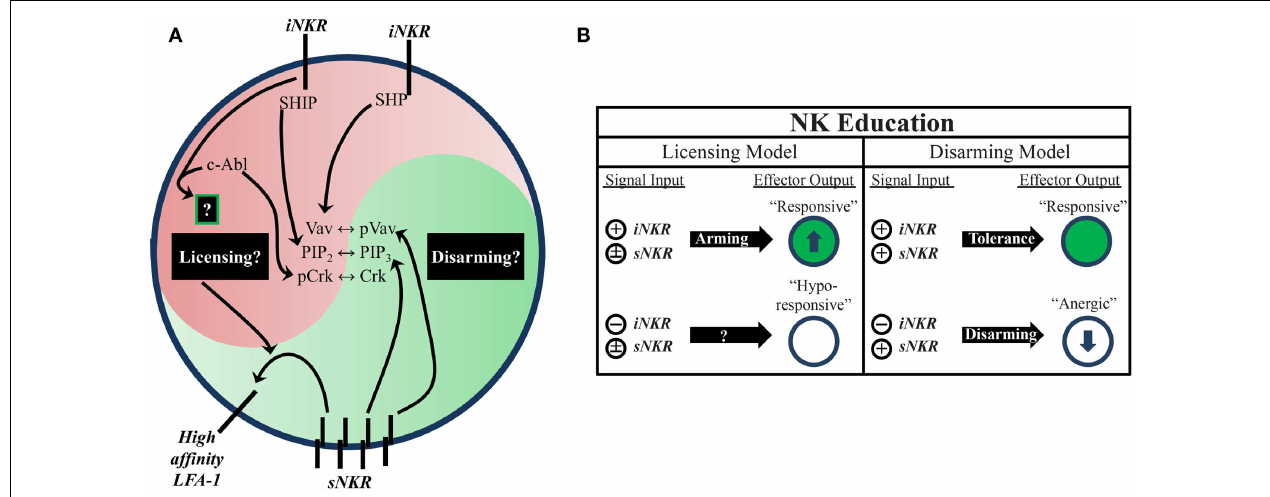
self-specific iNKR that has been recently established is the ability to enhance sNKR inside-out signaling to LFA-1 to promote adhesion and target recognition. (B) The balance of signals in NK cells determines their reactivity. NK that do not receive inhibitory signals can be activated in response